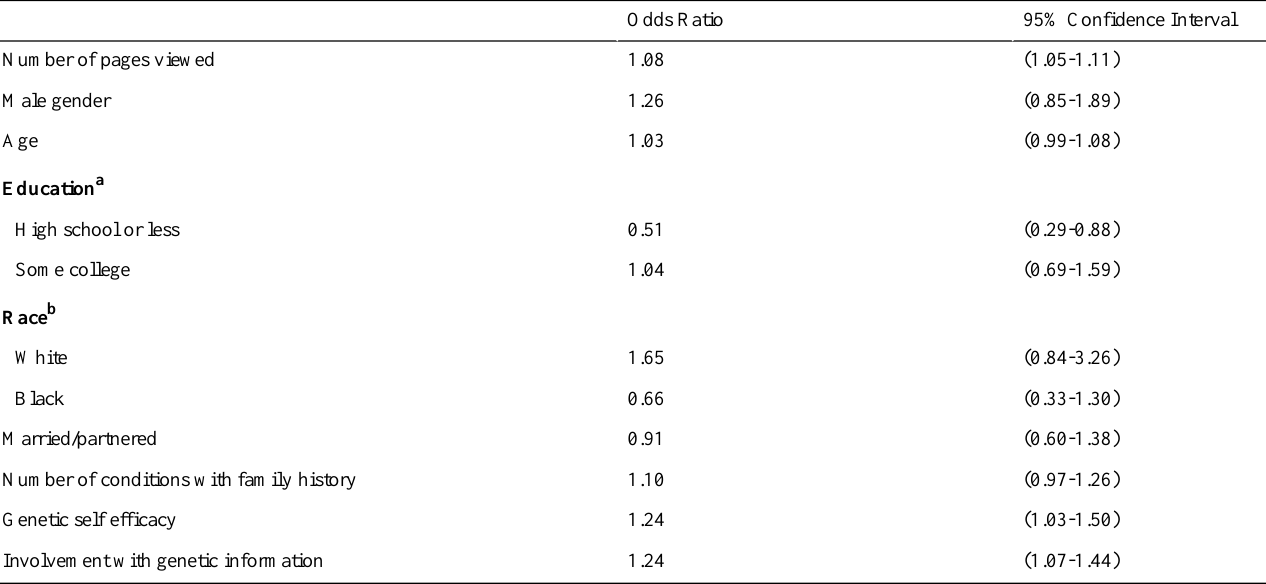
Table 3. Prediction of decision to test by number of pages viewed in a multivariate logistic regression model (n =